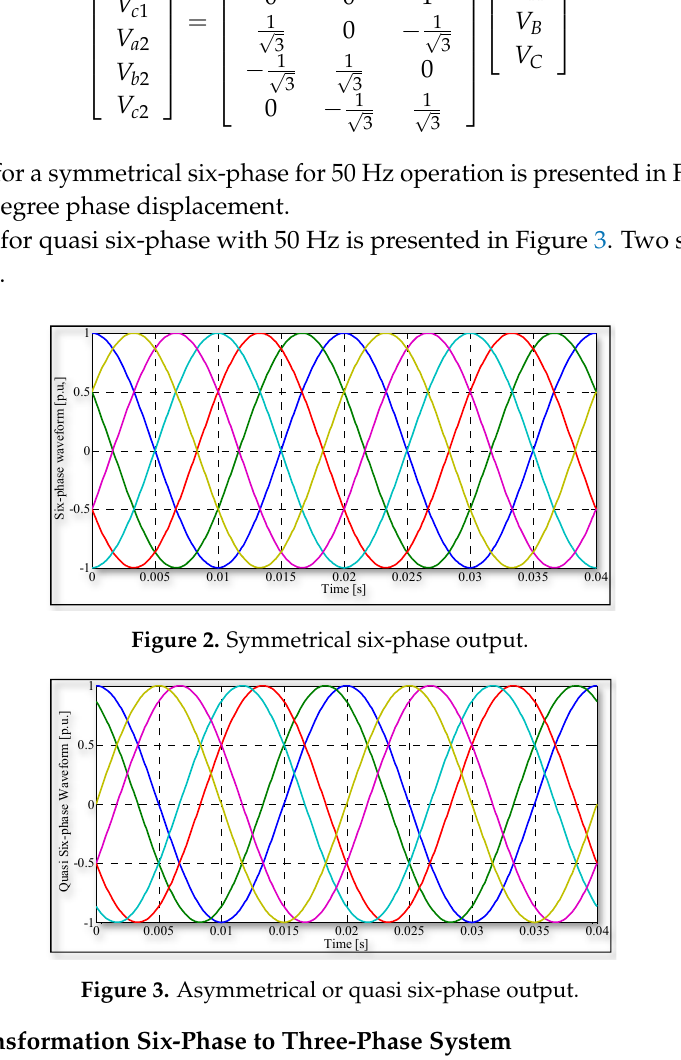
( b ) Figure 4. Symmetrical six-phase output with primary star; ( a ) connection diagram; ( b ) symbolic representation.